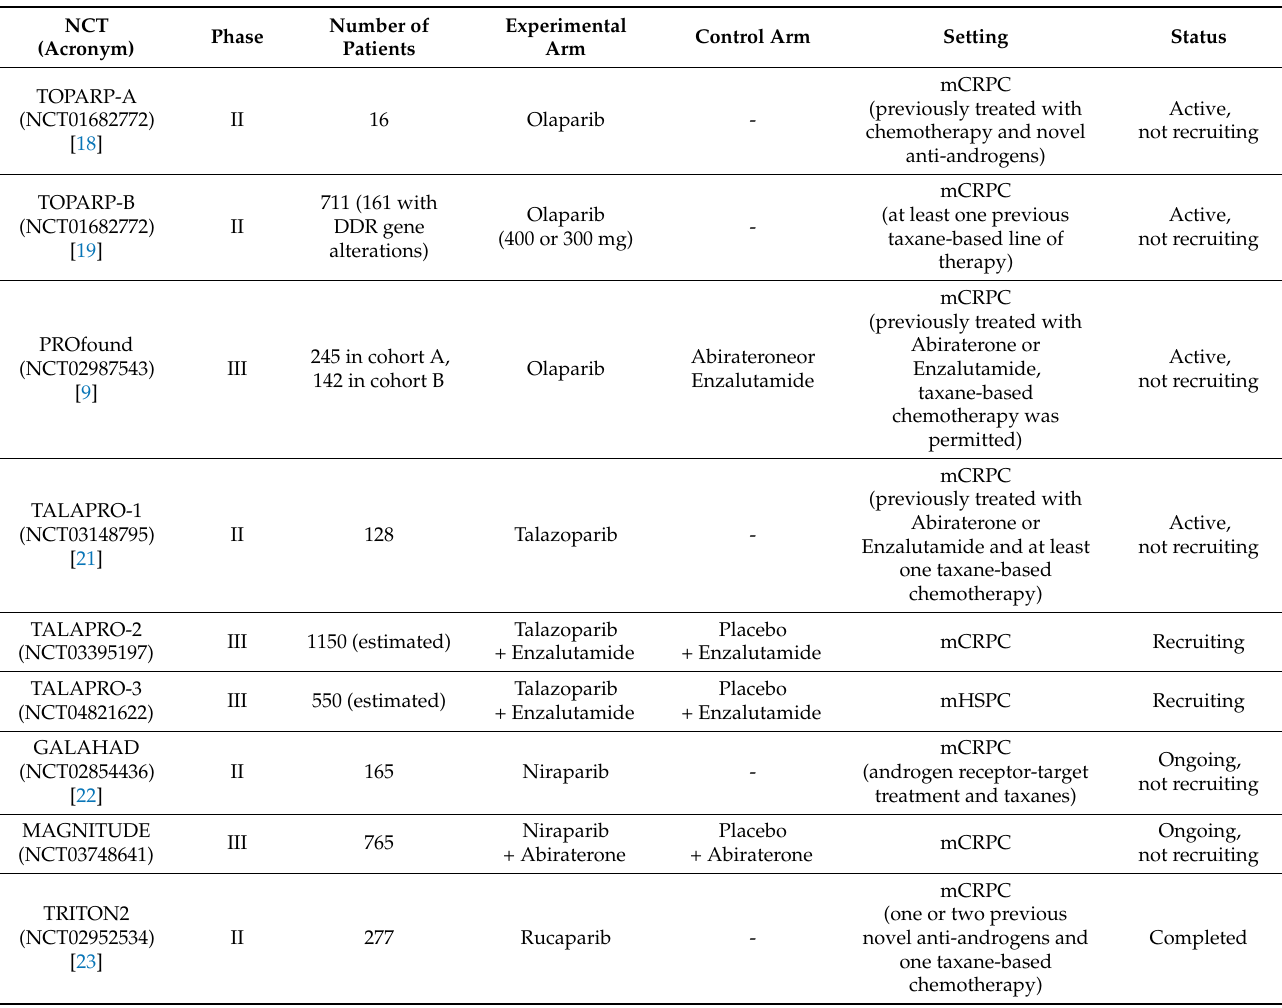
Table 1. Main trials testing various PARPi in metastatic prostate